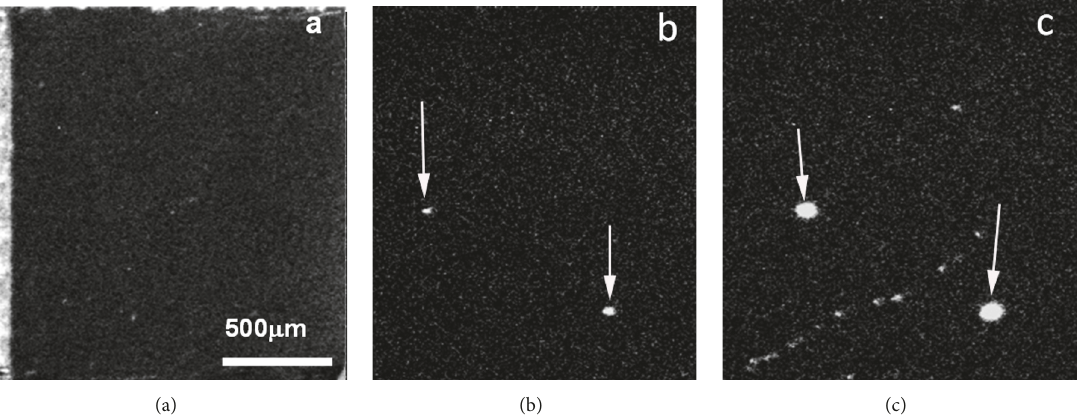
Figure 2: EL images of a solar cell fragment obtained at reverse bias 𝑈 𝑏 = 0V ( 1 ), 5 V (b), and 19 V (c). Type I breakdown sites are shown with white arrows.